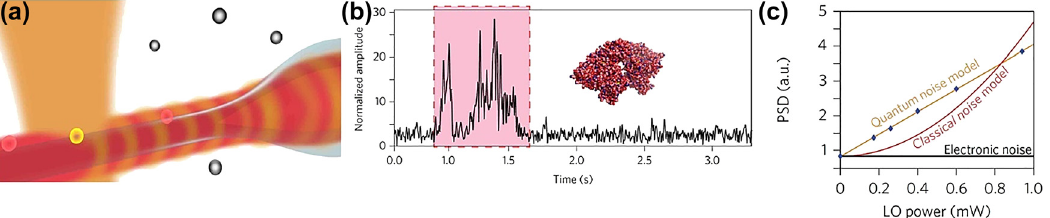
Figure 15: Tapered fibre single molecule detection